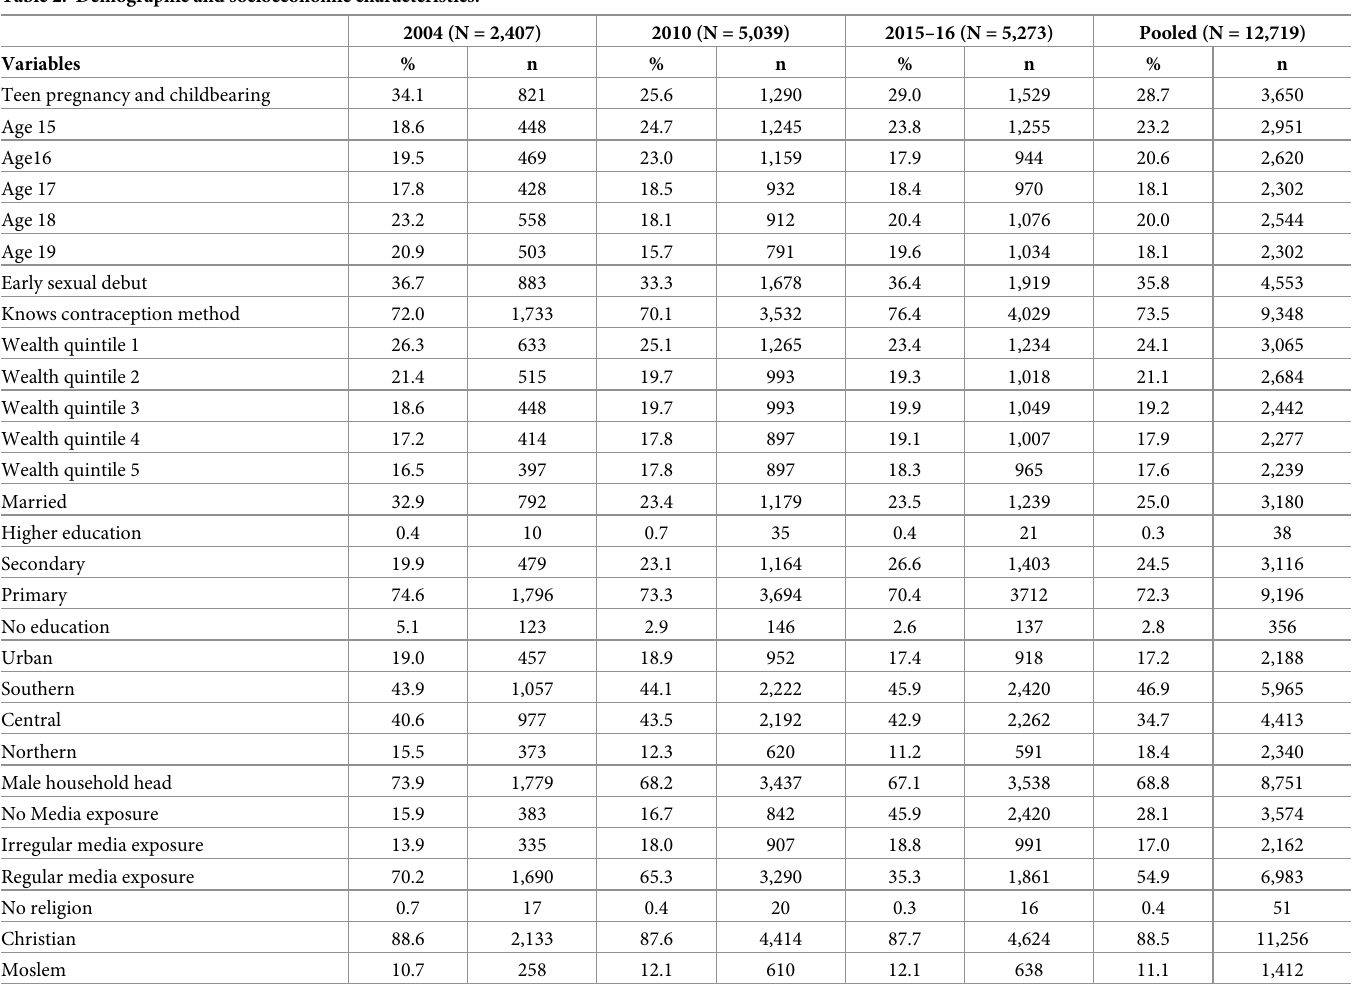
Table 2. Demographic and socioeconomic